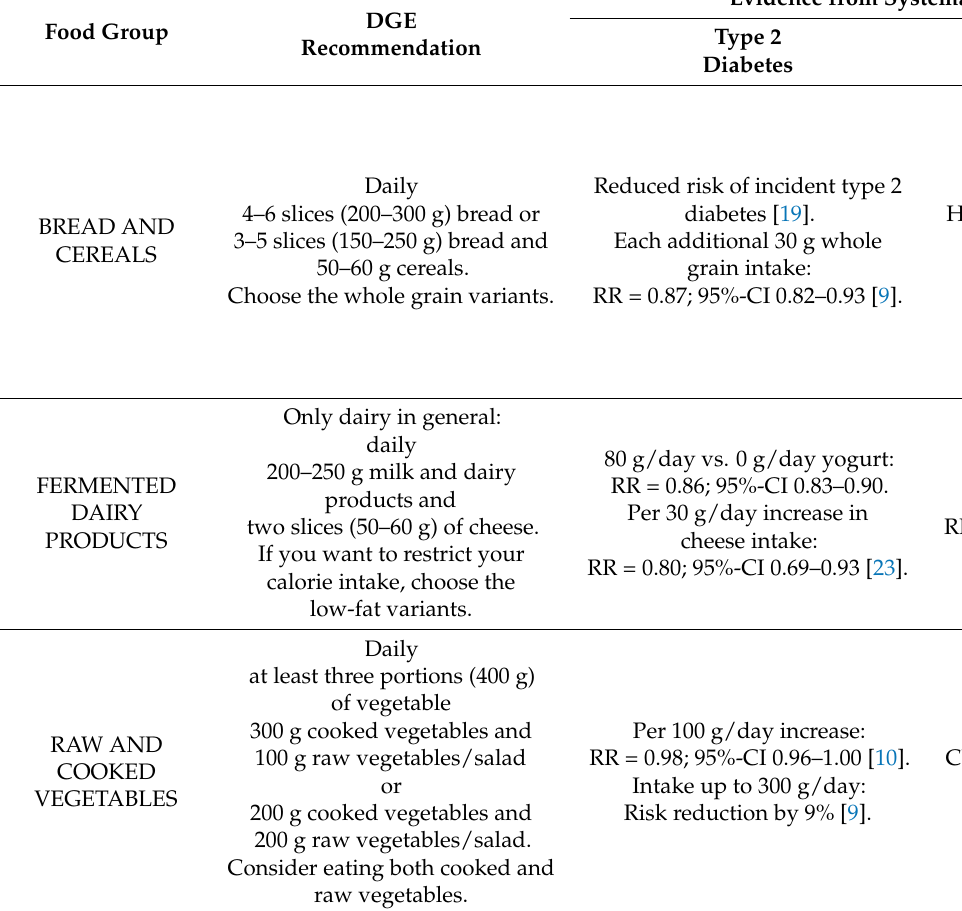
Table 1. Selected food groups for the diet score and their evidence